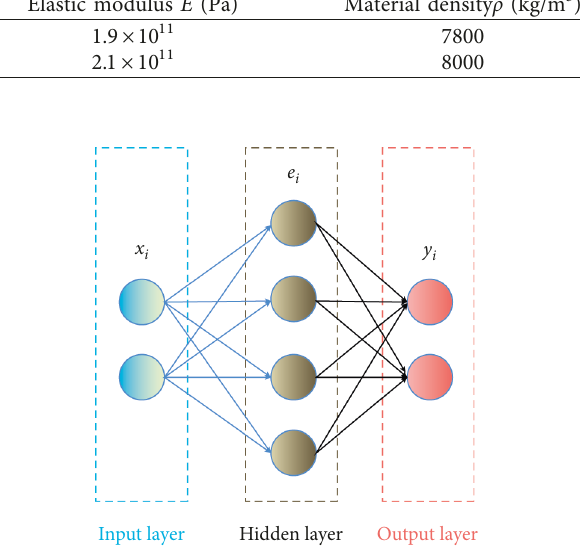
Figure 7: Working principle of the neural network.